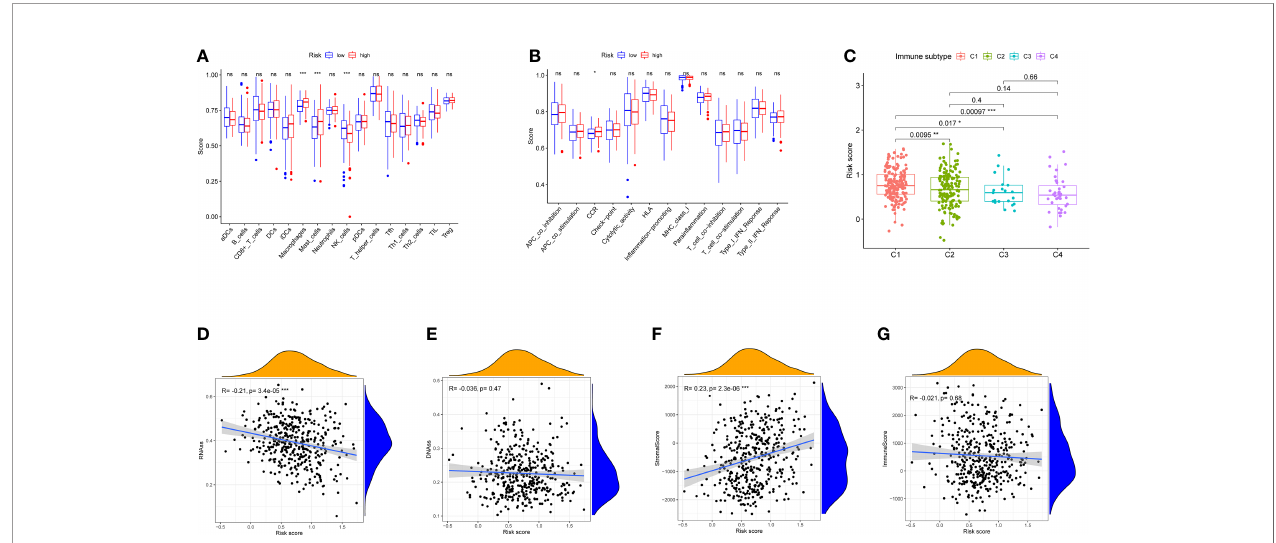
FIGURE 6 | Immune status between different risk groups and the association between risk score and tumor microenvironment in TCGA cohort. (A) The scores of 16 immune cells are shown in boxplots. (B) Thirteen immune-related functions are shown in boxplots. (C) Comparison of the risk score in different immune in fi ltration subtypes. (D – G) The relationship between risk score and RNAss, DNAss, stromal score, and immune score. p-values are shown as ns, not signi fi cant, *p < 0.05, **p < 0.01, and ***p <